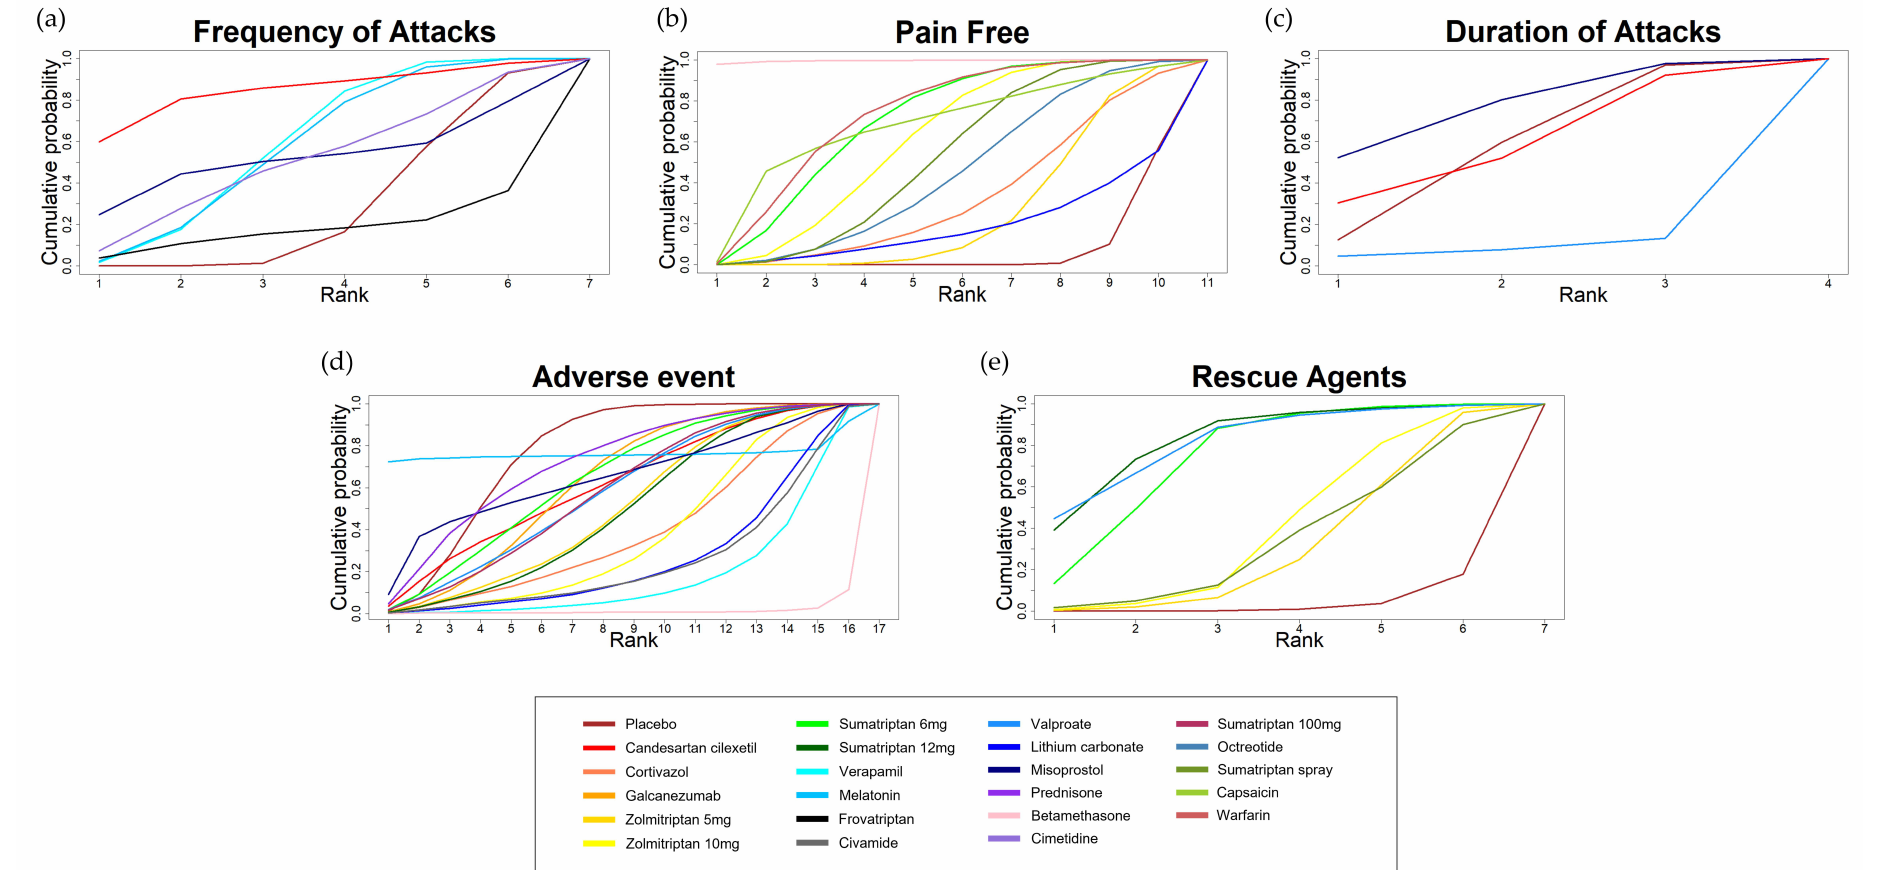
Figure 9. Cumulative rank with SUCRA (the surface under the cumulative ranking curve) for each treatment. The probability of each treatment distribution is displayed on the graph. ( a ) Frequency of attacks; ( b ) pain-free rate; ( c ) duration of attacks; ( d ) rescue agents; ( e ) adverse